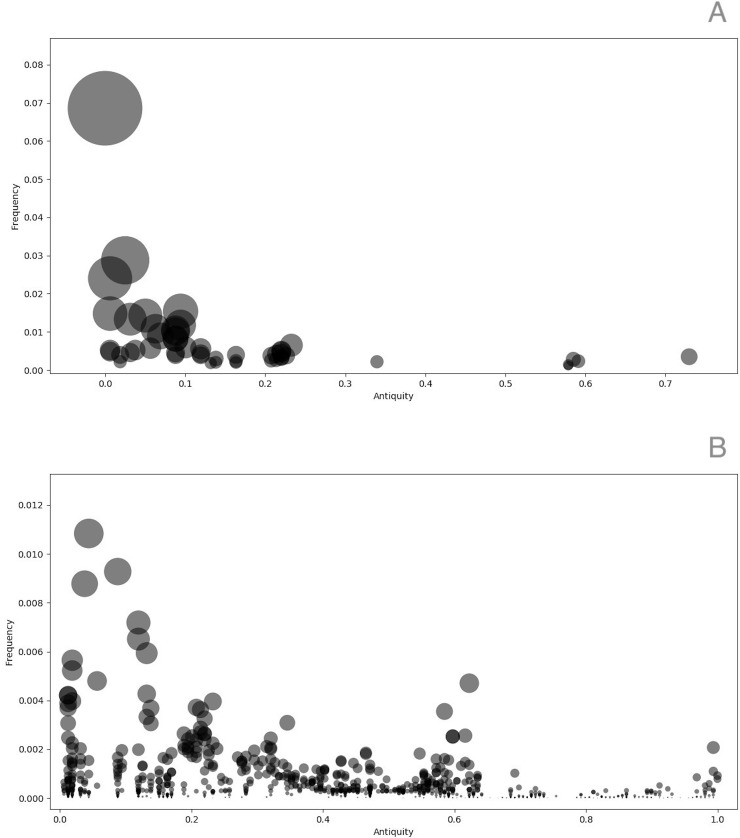
Antiquity and abundance of structural domains.A) Promiscuous and B) non-promiscuous domains. On the X-axes are antiquity assignments, i.e., how ancient each structural domain present in the universal enzymatic reactions is, as suggested by Caetano-Anolles et al [15]; a score of 0 represents an ancient event, whereas 1.0 represents recent domain emergence. On the Y-axis is the abundance (frequencies) of the superfamilies. The size of a circle represents the proportion of each domain in relation to the total protein domains.